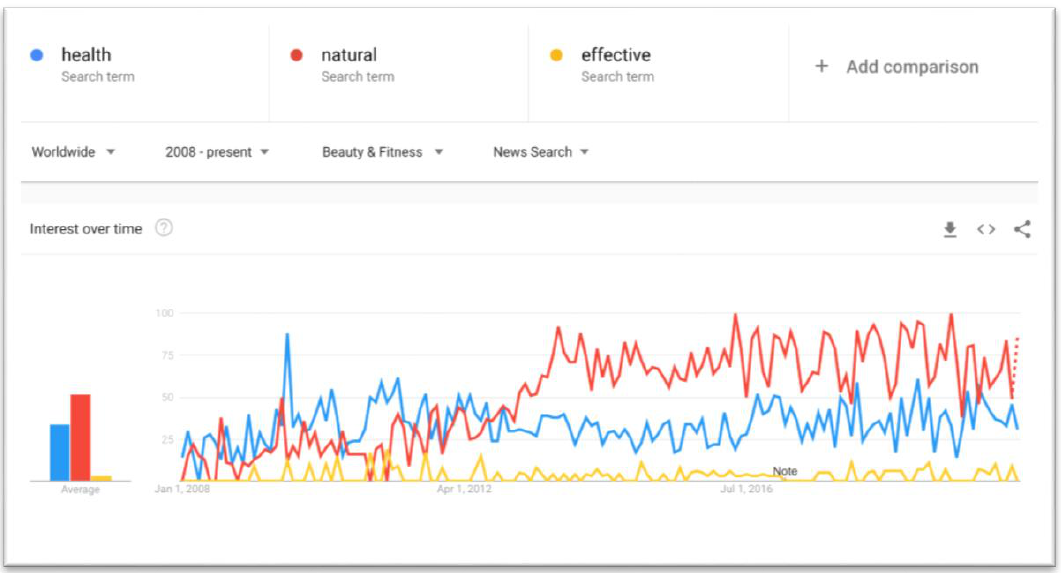
Figure1. Increasingfrequencyofinternetsearchesfor“health”and“natural”comparedto“effective”. Figure 1. Increasing frequency of internet searches for “health” and “natural” compared to “effective”. Source: keywords searches on Google News in the beauty and fitness category